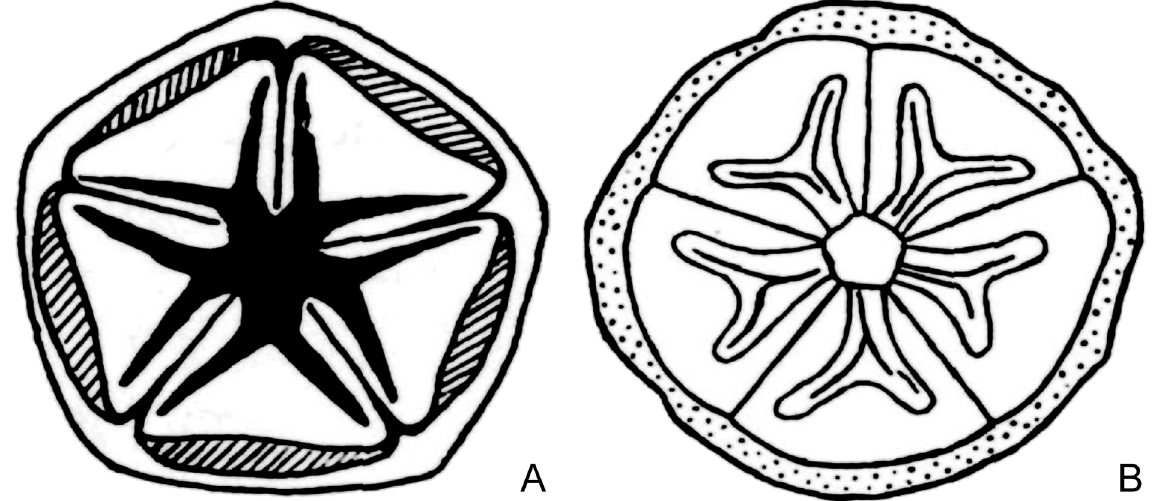
Fig. 4. Cross sections near aboral surface of radial circlet showing Y-shaped coelomic canals in the genus Discometra Gislèn, 1924. A . Discometra rhodanica (Fontannes, 1877). B . Discometra eggenburgensis (Schaffer, 1912). Modified from Sieverts-Doreck (1961) in which A was modified from Fontannes